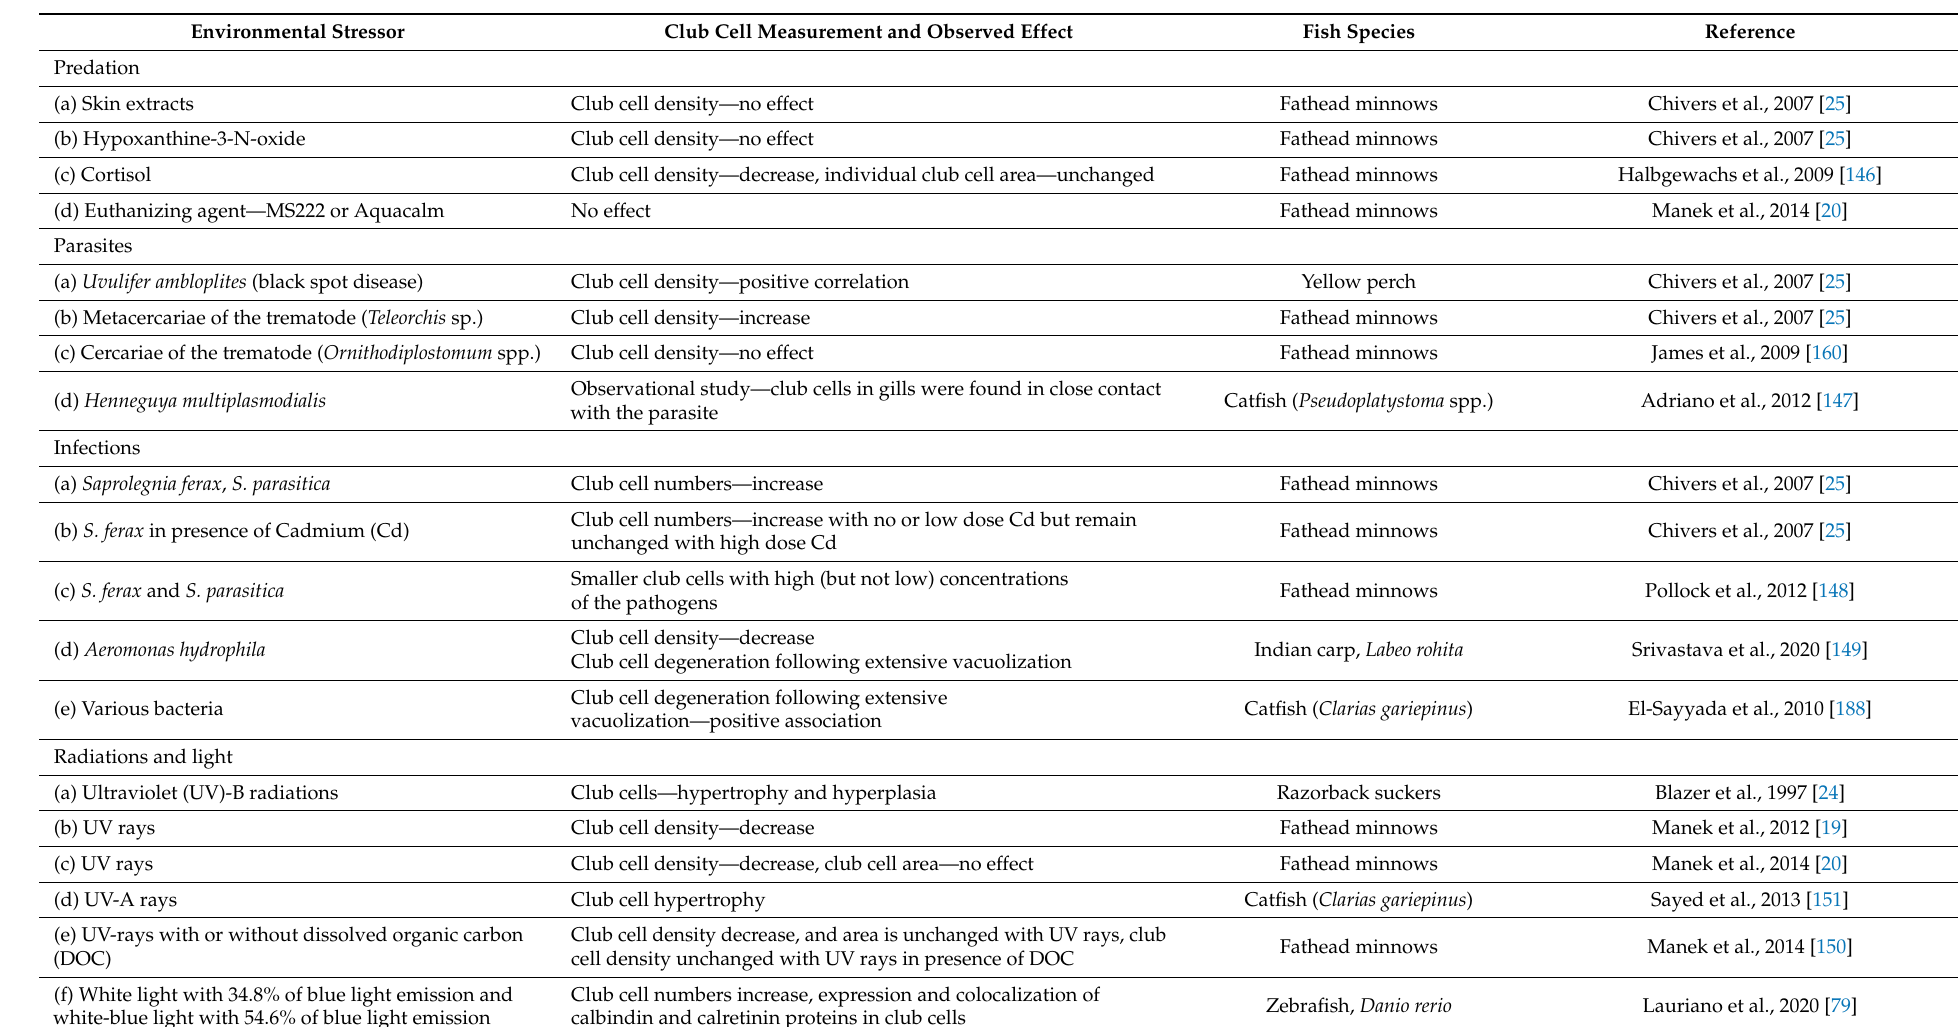
Table 2. Summary of environmental stressors and their effect on epidermal club cells in